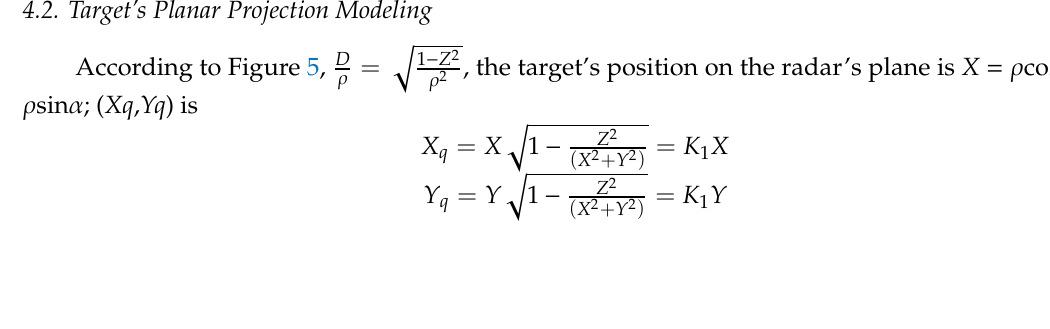
Figure 5. Target’s planar projection.